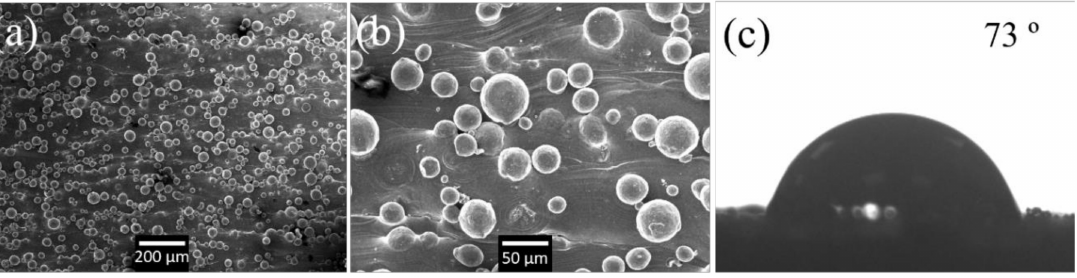
Figure 2. Scanning electron microscopy (SEM) image of the additive manufacturing (AM) surface